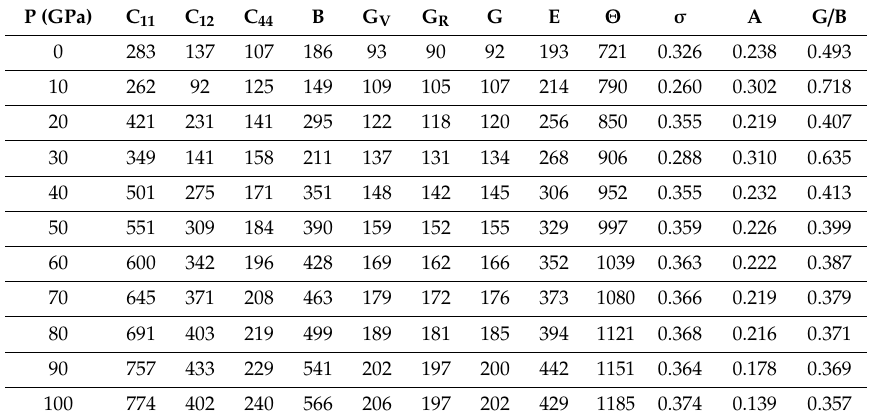
Table 3. The C ij (GPa), B (GPa), G (GPa), E (GPa), Θ , Poission ratio σ , anisotropy factor A and G / B of Co 2 Zr at various pressure.